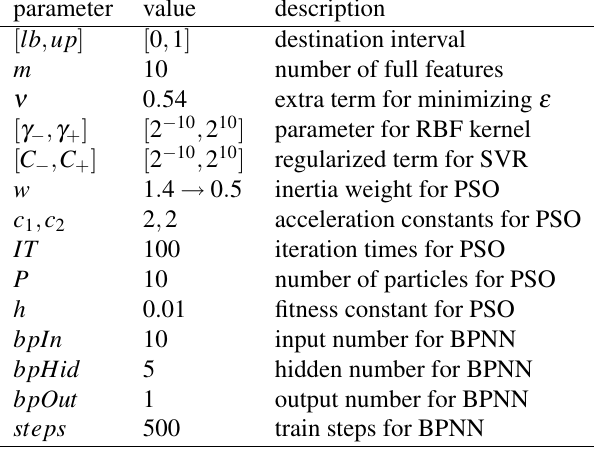
Table 2. Parameters